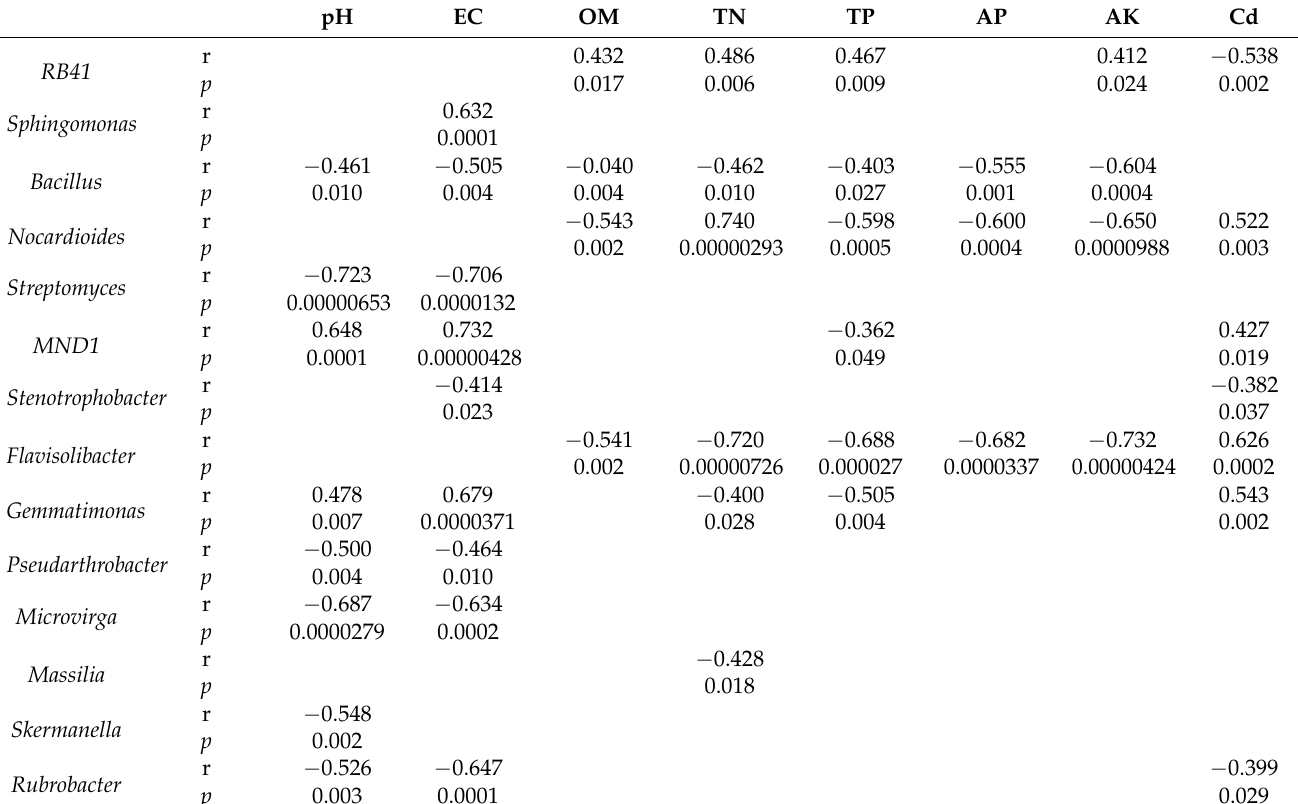
Table 6. Correlation coefficients of strains and environmental